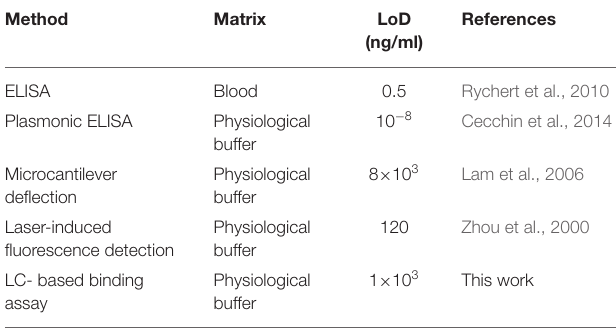
TABLE 1 | Comparison of present work with available HIV-1 detection techniques.